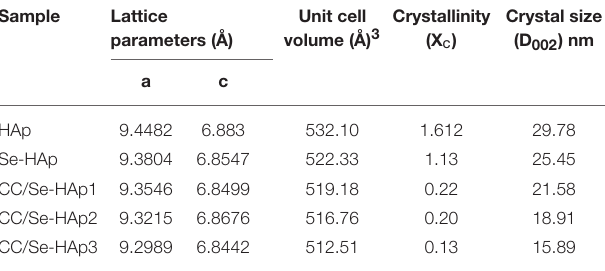
TABLE 1 | Summary of effect of selenium and catechins contents on the lattice parameters (a and c), unit cell volume, crystal size, and crystallinity of pristine HAp and catechins-modified selenium-doped HAp nanocomposites.